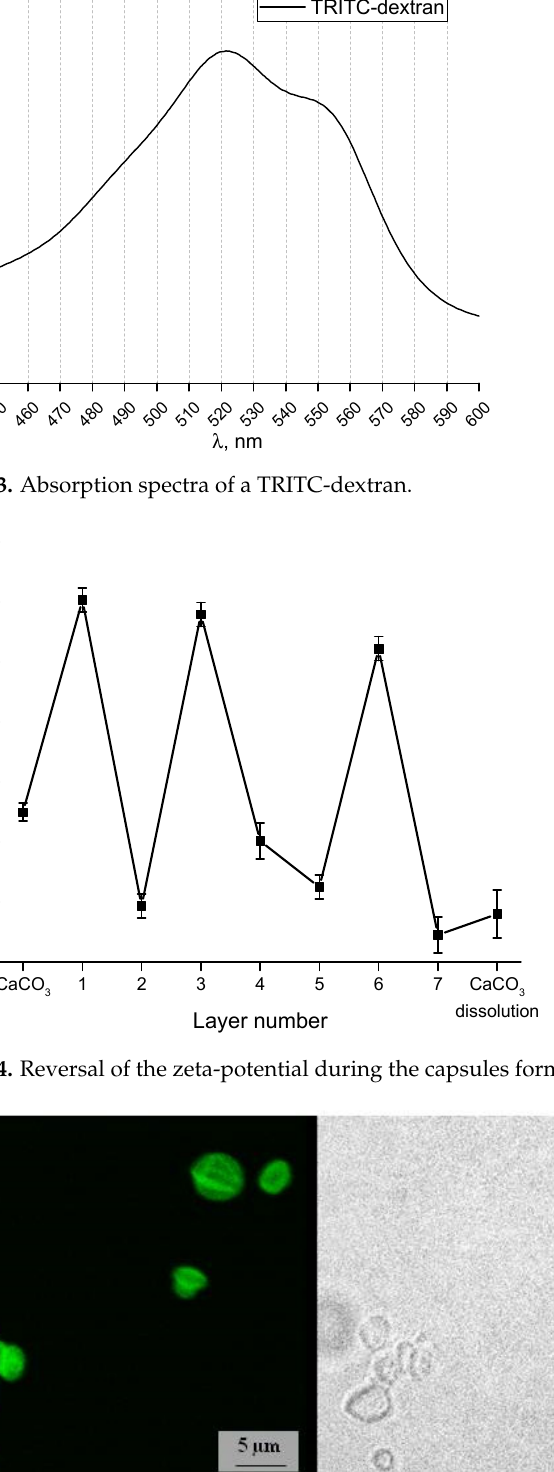
Figure A5. CLSM image and optical image of PAH/PSS/PAH/MNP/PSS/PAH/PSS capsules loaded with TRITC-dextran.